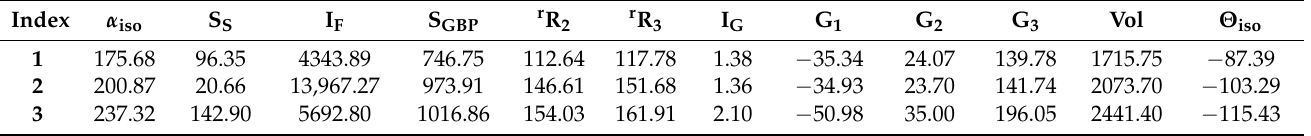
Table 1. Correlation coefficient (R 2 ) between the isotropic molecular polarizability ( α iso , in Bohr 3 ) and ITA quantities (in a.u.), molecular volume (Vol, in Bohr 3 /mol), and the isotropic quadrupole moment ( Θ iso , in a.u.) at S 0 for all the systems in Schemes 1 and